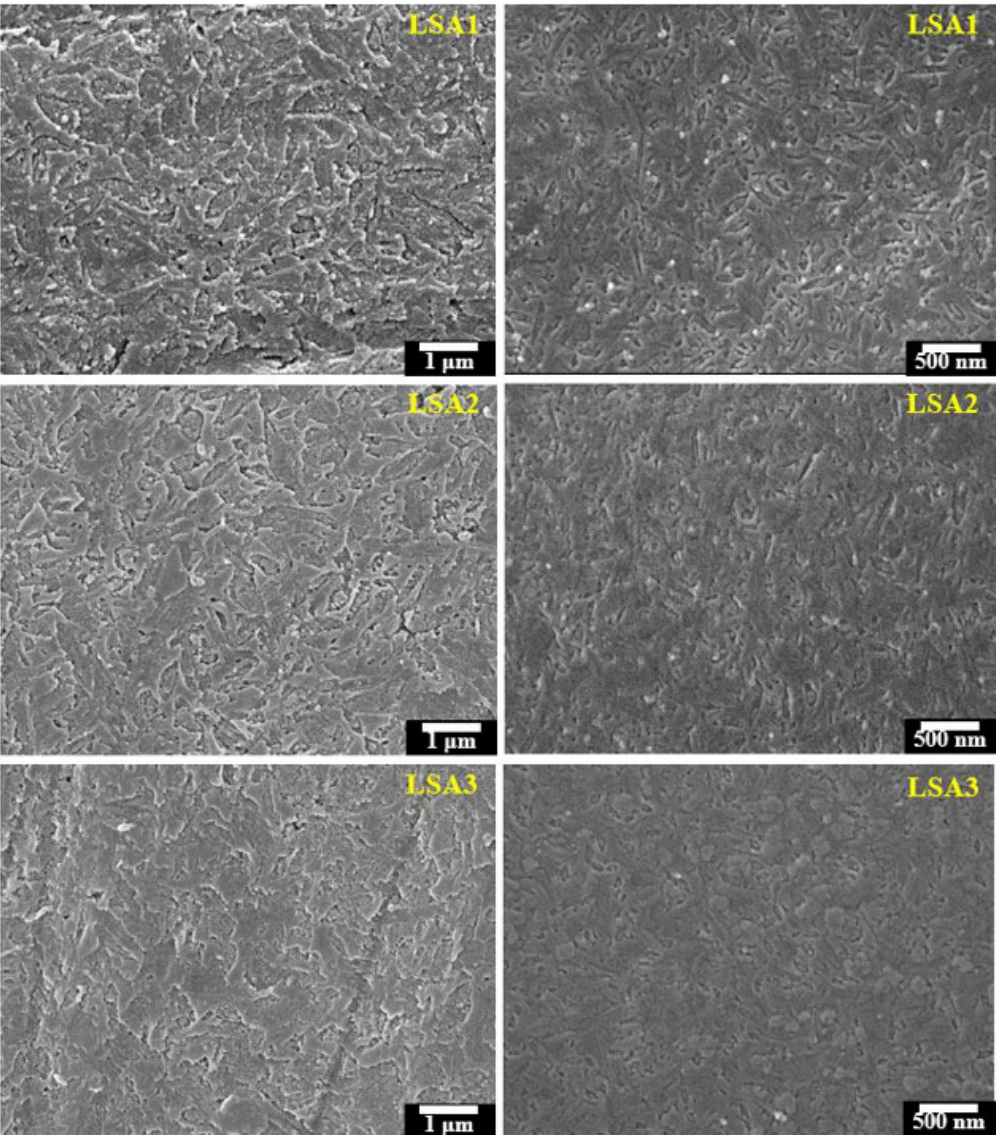
Figure 3. Micrographs of the surfaces ( left ) and fracture of the glass–ceramic samples ( right ) after heat treatment at 600/800 °C.